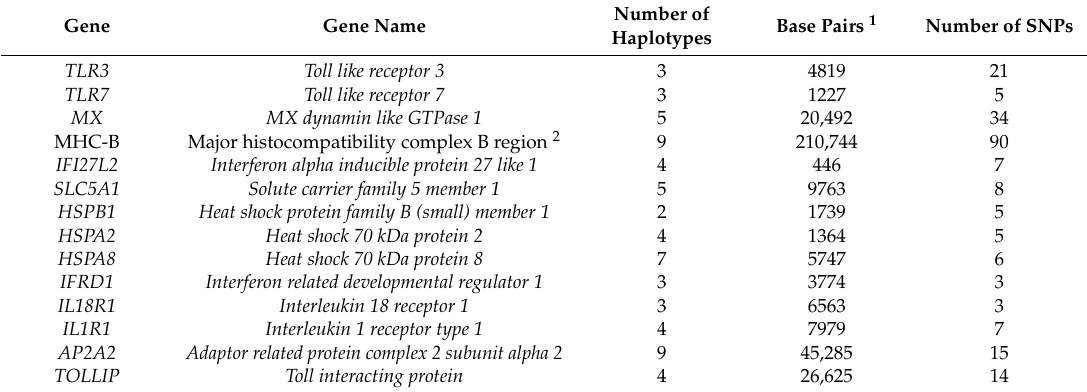
Table 1. Gene, haplotype, and single nucleotide polymorphism (SNP)